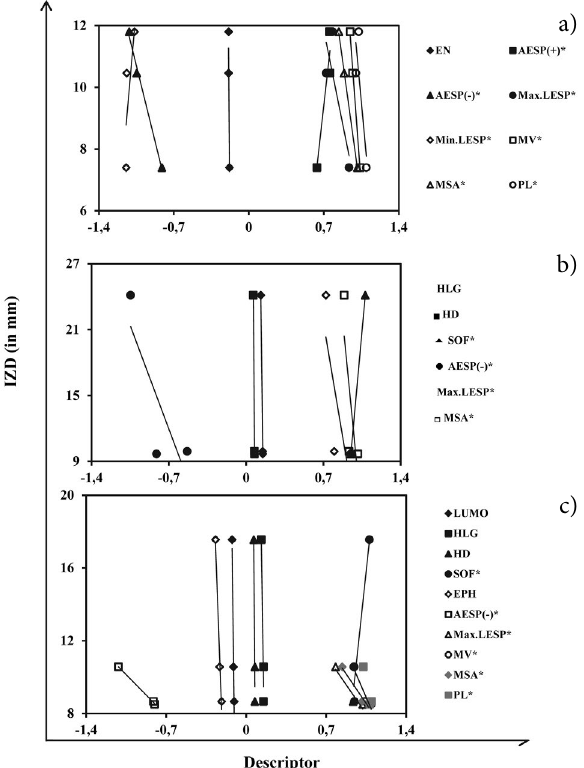
Figure 5. The correlation between descriptors and the IZD values of the ligands 4b , f , g and 4b , f , h and 4b , d , f , g against Gram-positive bacteria 1447 (a), 1297 (b) and 1665 (c),